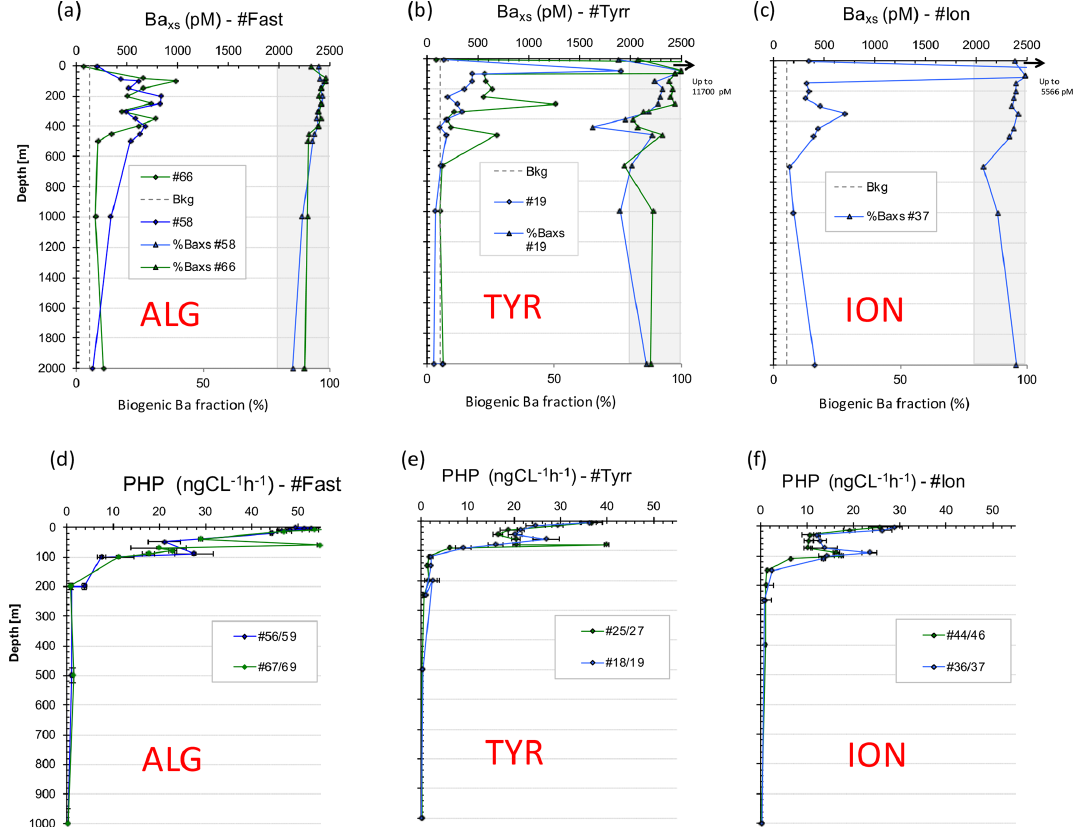
Figure 3. (a–c) Ba xs (pM) and (d–f) PHP (ngCL − 1 h − 1 ) profiles in the upper 2000 and 1000m of the water column respectively at long- duration stations, Fast, Tyrr and Ion. (a–c) The dashed grey line represents the Ba xs background (Bkg), and the grey area represents the fraction for which Ba xs is mostly